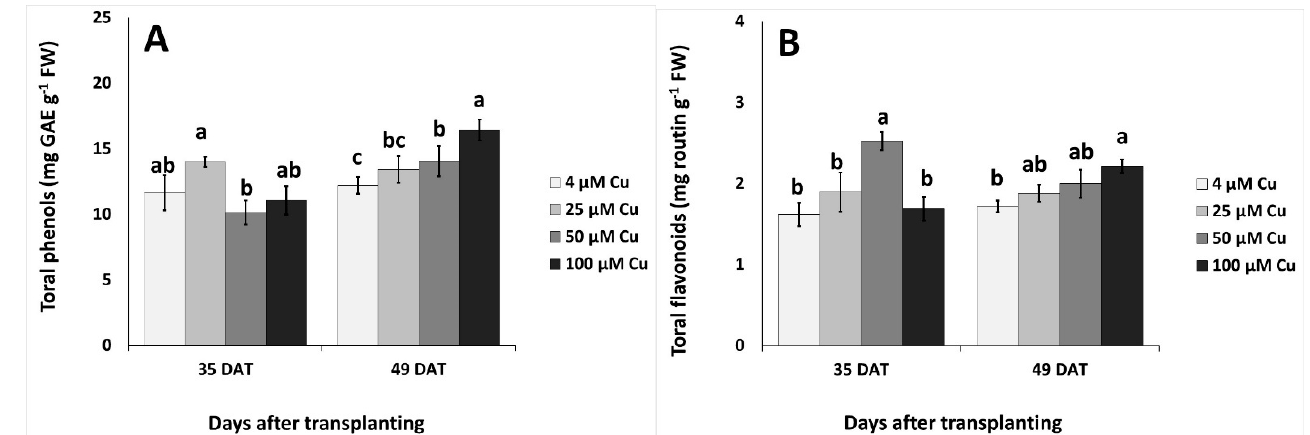
Y At each sampling date, values ( n = 6) in columns followed by different letters are significantly different, p < 0.05, for